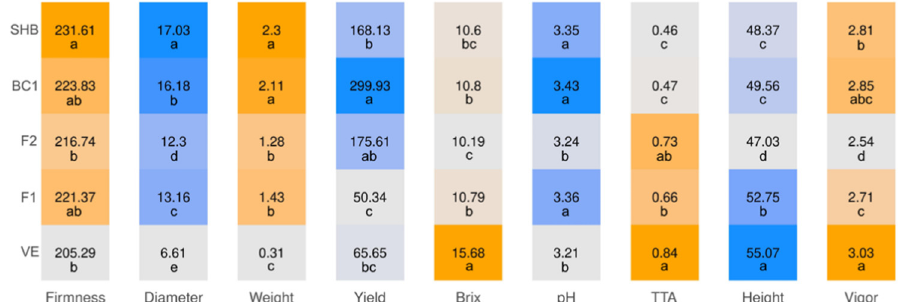
Figure 4. Average values obtained by breeding stage for nine fruit quality- and plant fitness-related traits. Breeding values obtained across crop seasons for nine traits for five blueberry breeding stages: V. elliottii (VE), F 1 , F 2 , BC 1 , and Southern highbush (SHB) families. Darker colors (either blue or orange) correspond to higher values. Treatments with the same letters are not statistically different at alpha = 0.05.